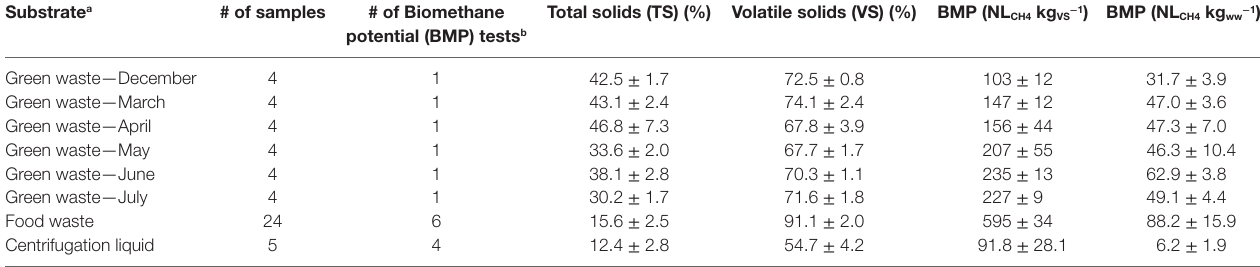
TaBle 3 | Characteristics of substrates that were co-digested at the dry anaerobic digestion plant Villeneuve. substrate a # of samples